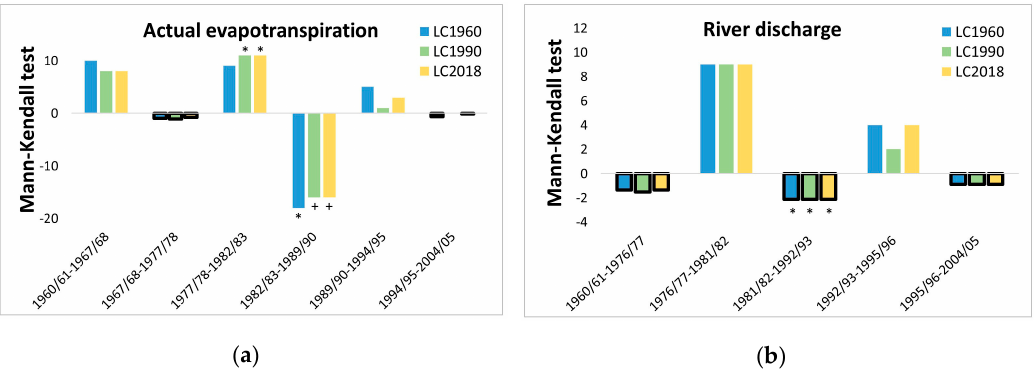
Figure 13. Results of Mann-Kendall test for actual evapotranspiration ( a ) and river discharge ( b ) for LC1960, LC1990, and LC2018. No border in columns indicates S test and black border Z test. (*) and ( + ) symbols indicate if the trend is significant at the α = 0.05 level and α = 0.1 level, respectively.